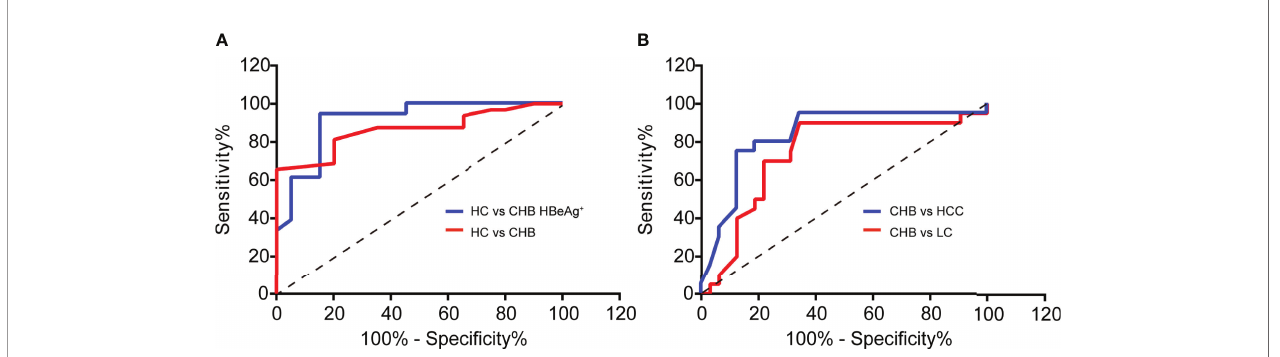
FIGURE 5 | Serum ATP contributes to diagnosing CHB and predicting its poor clinical outcome. (A) ROC curves to validate the diagnostic value of Healthy control (HC) (n = 20) against chronic hepatitis B (CHB) (n = 32) ( p < 0.0001) or HBeAg-positive CHB (n = 20) ( p < 0.0001). (B) ROC curves to validate the diagnostic value of CHB (n=32) against liver cirrhosis (LC) (n = 20) ( p = 0.0039) or hepatocellular carcinoma (HCC) (n = 20) ( p